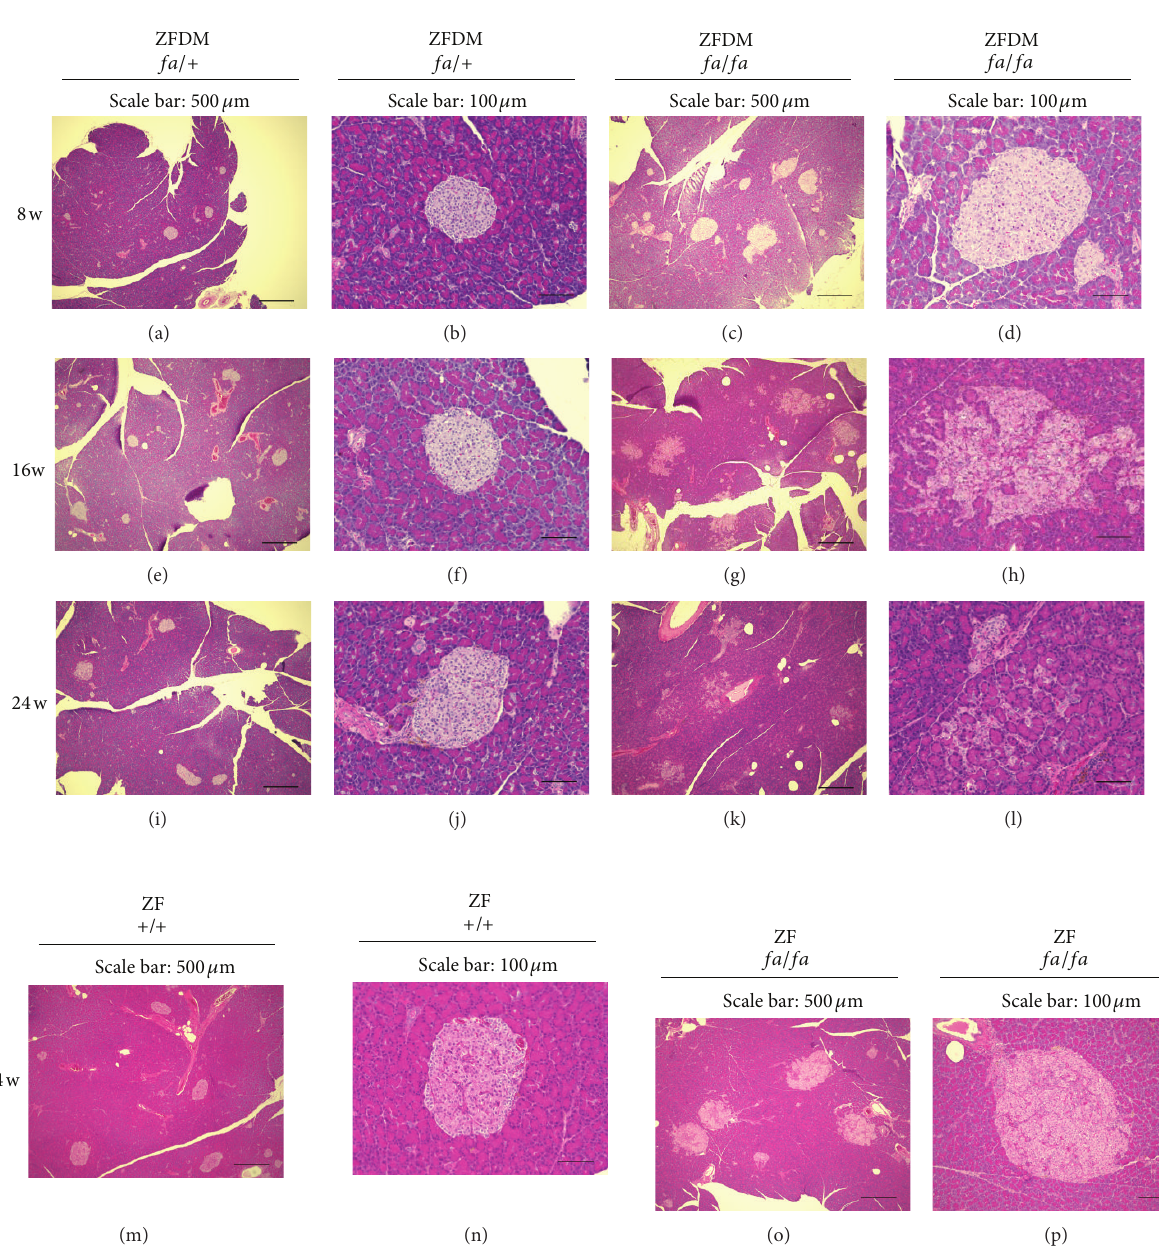
Figure 6: Histological characterization of the pancreas of the ZFDM and ZF strains. Representative pancreas histology of fa/ + (a, b, e, f, i, and j) and fa/fa (c, d, g, h, k, and l) male rats in the ZFDM strain and +/+ (m and n) and fa/fa (o and p) male rats in the ZF strain. Hematoxylin and eosin